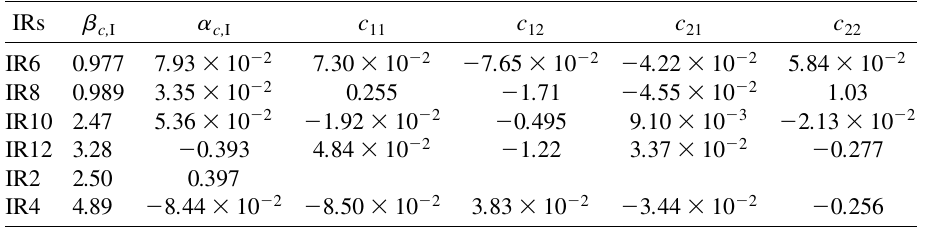
TABLE I. Measured Twiss and coupling parameters at the IR